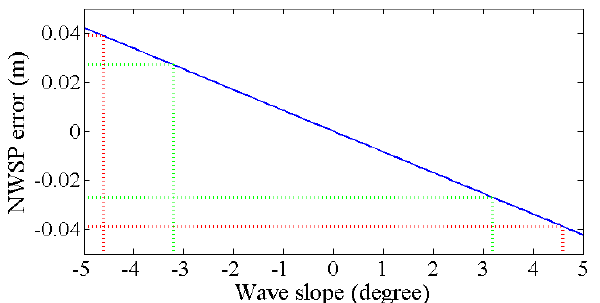
Figure 7. NWSP error induced by ignoring the wave slope. The green and red dotted lines denote the error range when the wind speed is at 20 km/h and 30 km/h, respectively.